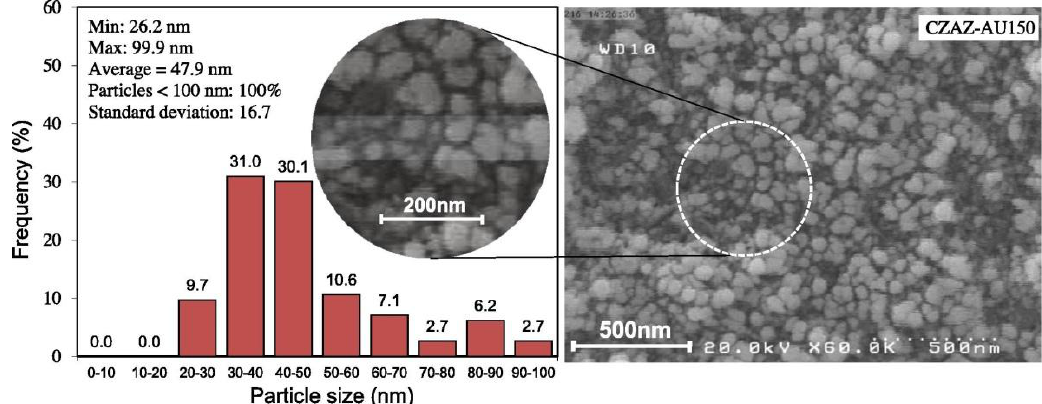
Figure 14. Surface particle size distribution histogram of synthesized CZA/HZSM-5 nanocatalyst using acetate precursor and ultrasound irradiation power of 150 W (CZAZ-AU150). Reprinted from